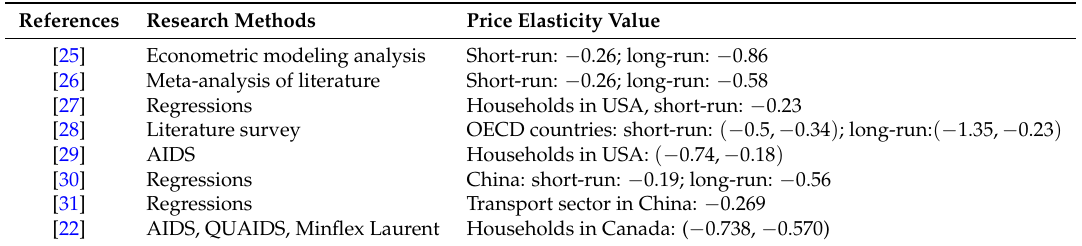
Table 1. Some price elasticities of gasoline demand from earlier studies. AIDS, Almost Ideal Demand System; QUAIDS, Quadratic